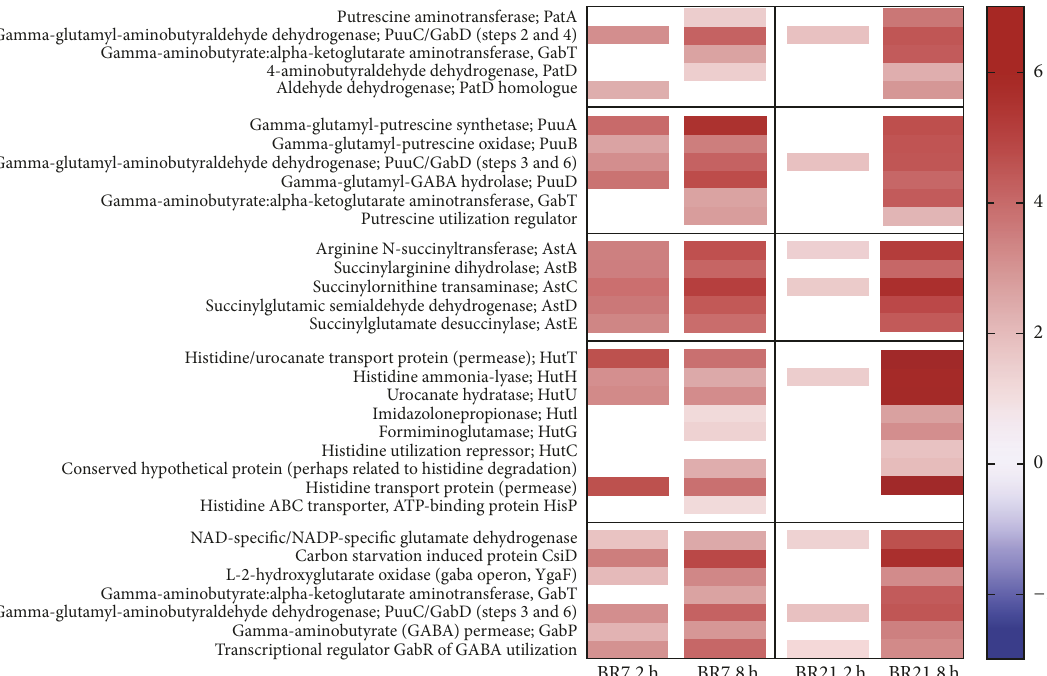
Figure 5: Transcriptional response after lethal imipenem exposure is associated with key metabolites entering the TCA pathway via increased expression of glutamate/ 𝛾 -aminobutyrate (GABA) catabolic pathways : transaminase pathway of putrescine degradation (section 1, lines 1–5), glutamylated putrescine pathway of putrescine degradation (section 2, lines 6–11), arginine degradation pathway to glutamate (section 3, lines 12–16), histidine degradation pathway to glutamate (section 4, lines 17–25), and glutamate flux to TCA, including the GABA shunt operon (section 5, lines 26–32). Illustrations to guide the reader through these pathways are provided in cited research